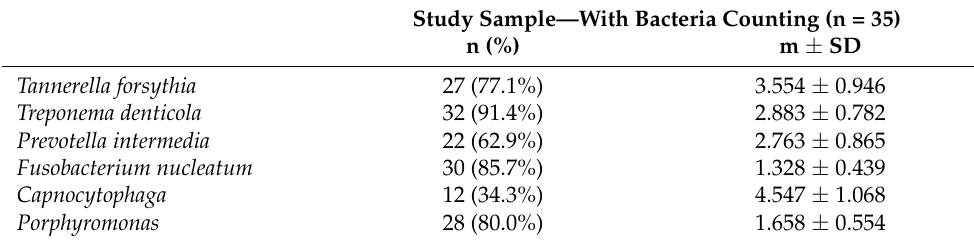
Table 3. Bacteria identified in the study